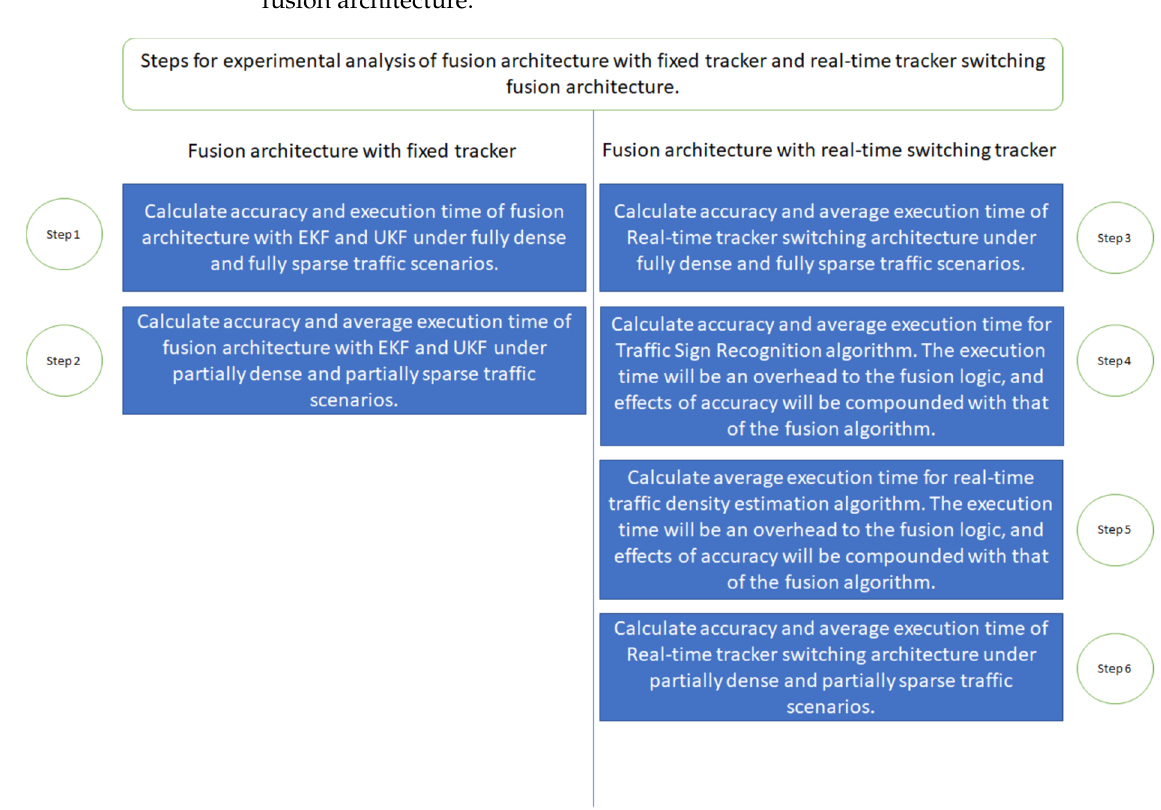
Figure 9. Steps followed for critical analysis of the fusion architecture with tracker switching. To commence, we calculate the accuracy and execution time of the fusion architecture with the fixed EKF and UKF tracker under fully dense and fully sparse traffic